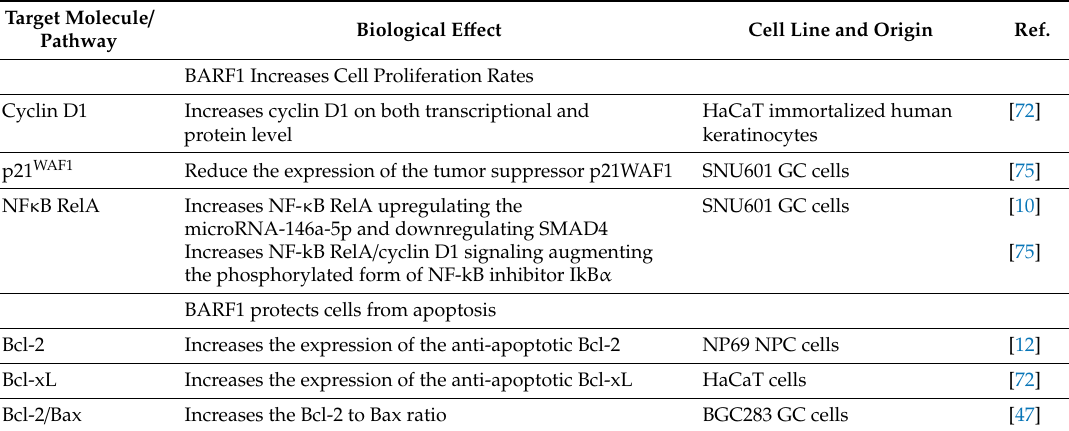
Table 1. Contribution of BARF1 expression to epithelial cell carcinogenesis and impaired host immune